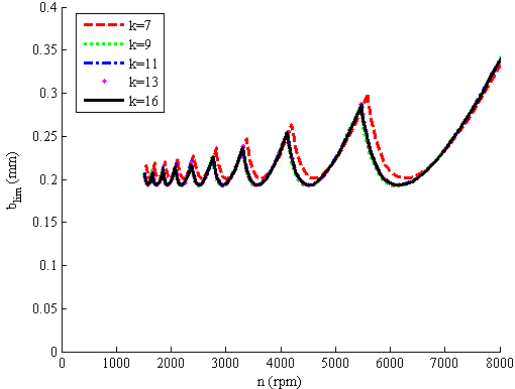
Figure 7. Chatter stability for different iteration numbers.